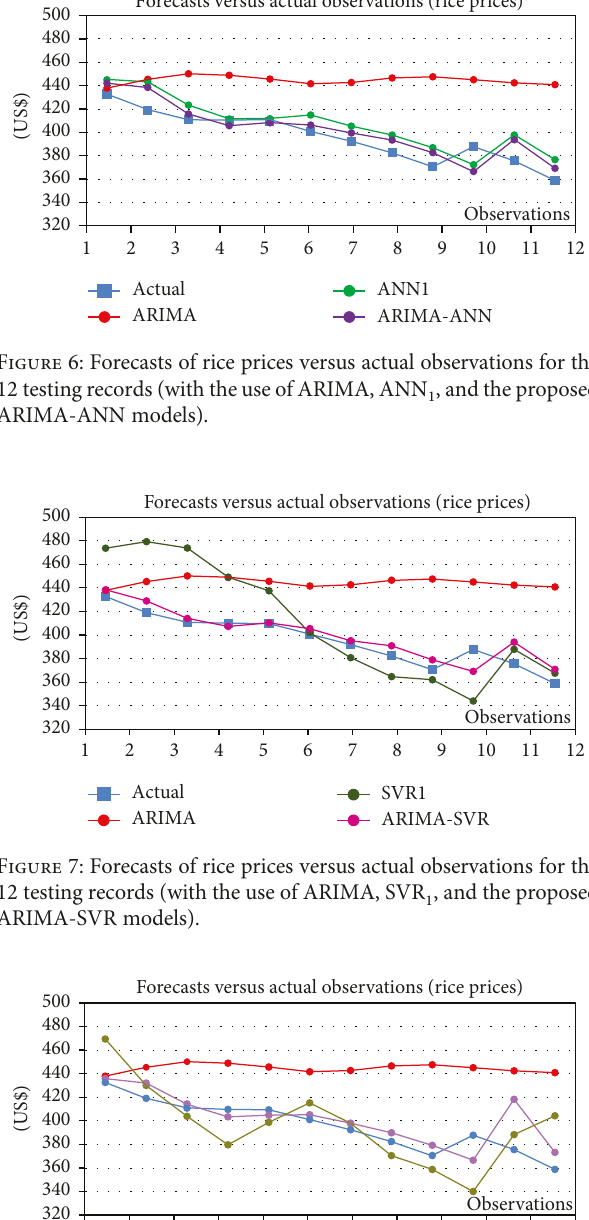
Figure 8: Forecasts of rice prices versus actual observations for the 12 testing records (with the use of ARIMA, MARS proposed ARIMA-MARS